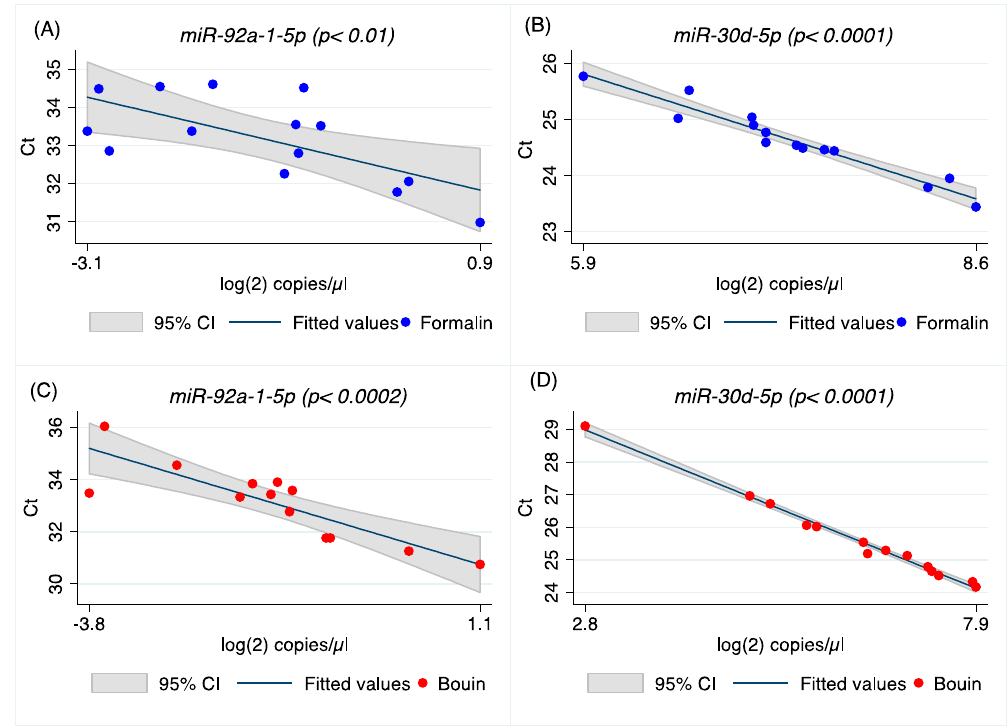
Figure 5. Scatter plot and linear prediction with 95% confidence interval of real-time and ddPCR results for miR-92a-1-5p and miR-30d-5p in formalin- ( A,B ) and Bouin’s-fixed tissues ( C,D ), respectively. Table 4. Results on regression analyses comparing RT-qPCR and RT-ddPCR in paired formalin- and Bouin’s-fixed tissues.